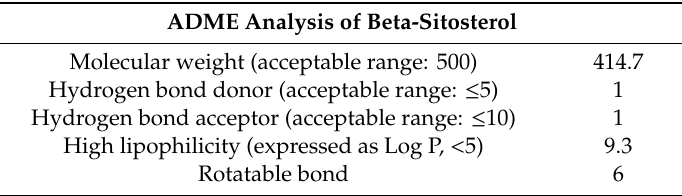
Table 10. ADME analysis of beta-sitosterol isolated from B. pilosa